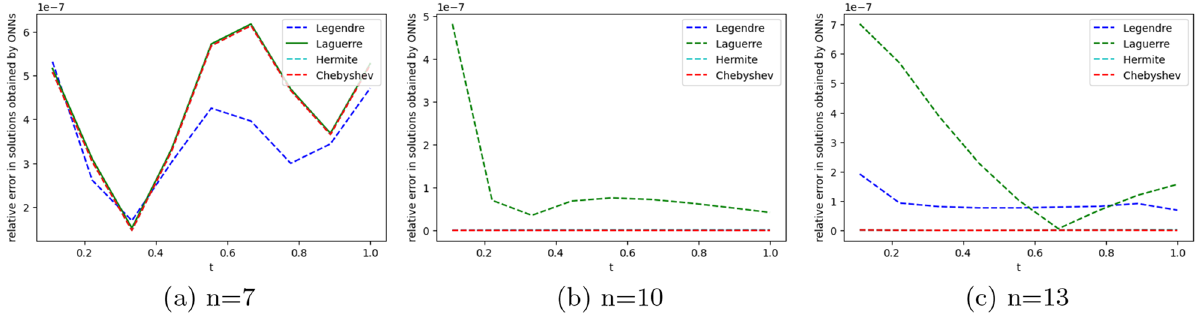
Figure 16. Error graph of z 1 ( t ) for different orthogonal neural networks with different numbers of neurons for Example 7.3.